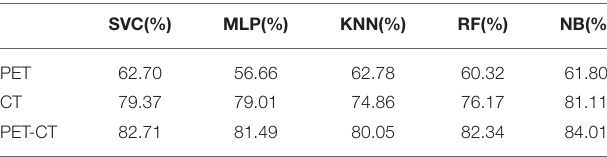
TABLE 4 | Classification performance of different modal images for lung cancer